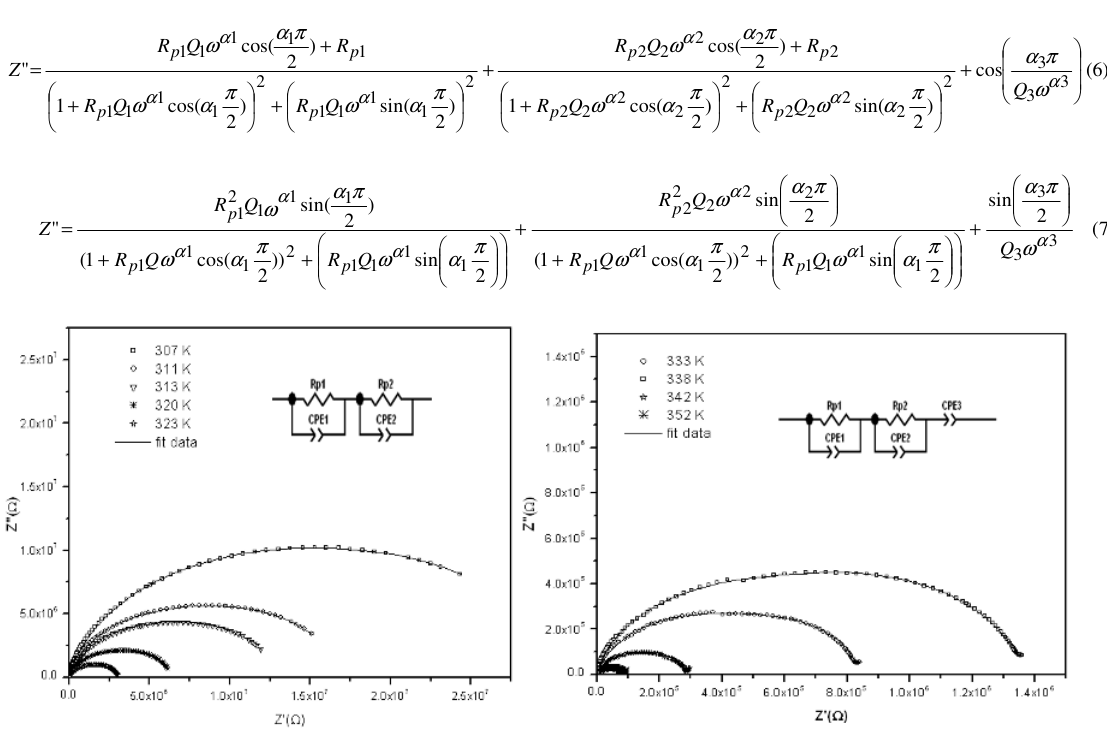
Fig.6. Experimental and simulation impedance data for [C 2 H 10 N 2 ]Cd(SCN) 2 (Cl) 2 at different temperatures. The insets show the proposed equivalent